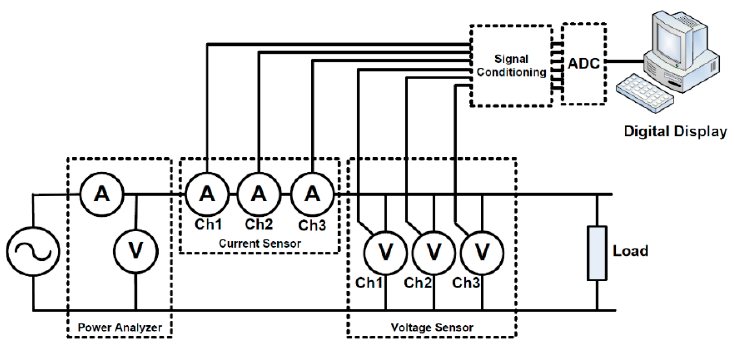
Figure 6. The measurement system used for the voltage and current sensor calibration.